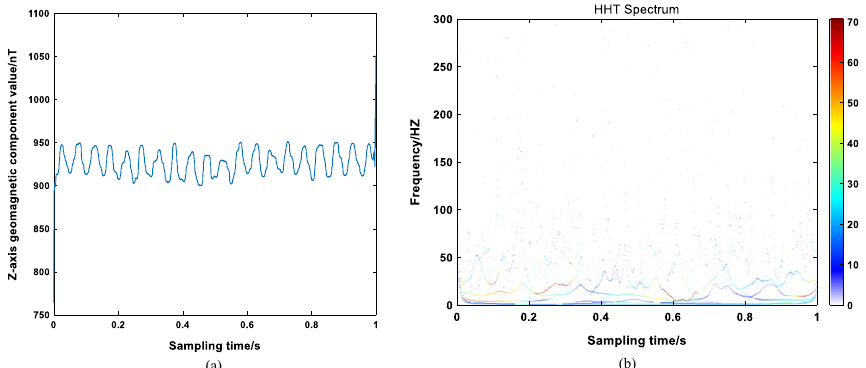
Fig. 15 Geomagnetic measurement signal and HHT spectrum after two IMMF processing